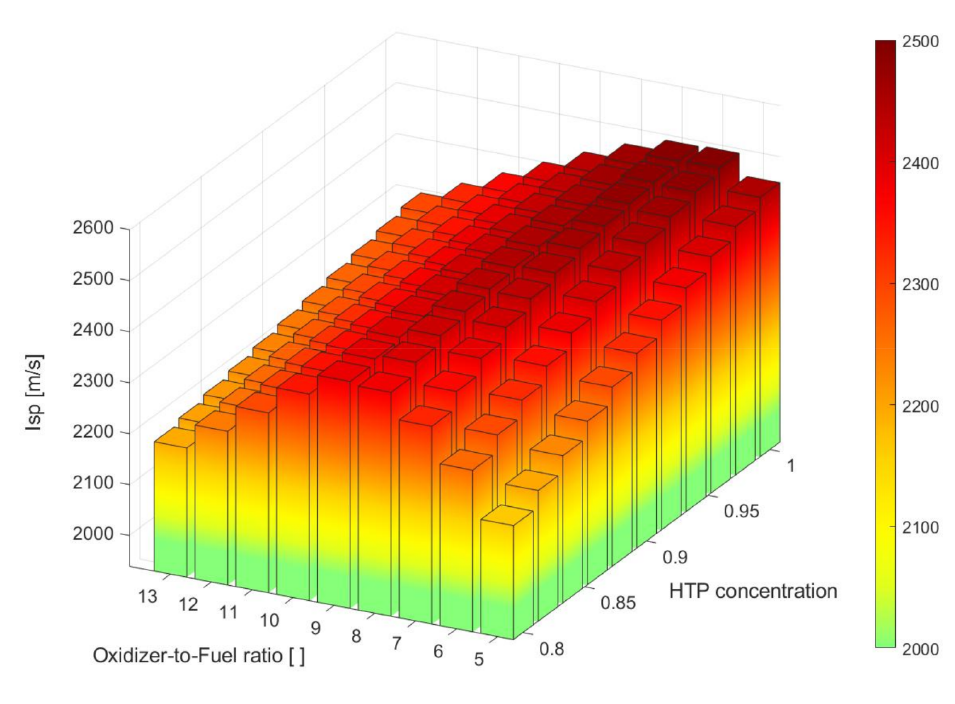
Figure 1. Theoretical performance of 98% HTP hybrid propulsion using PE as